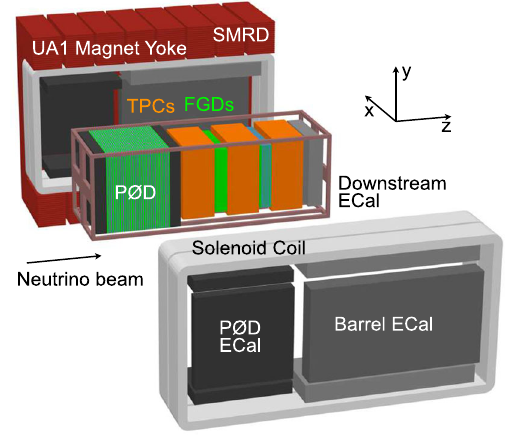
Fig. 49 Fine-Grained scintillator detector (FGD) and TPC comprise the tracking system. The π 0 detector (P0D) is a sandwich of water bag, lead, and scintillator tracking system. The whole detector is inside a large aperture magnet, which is instrumented with scintillators. This